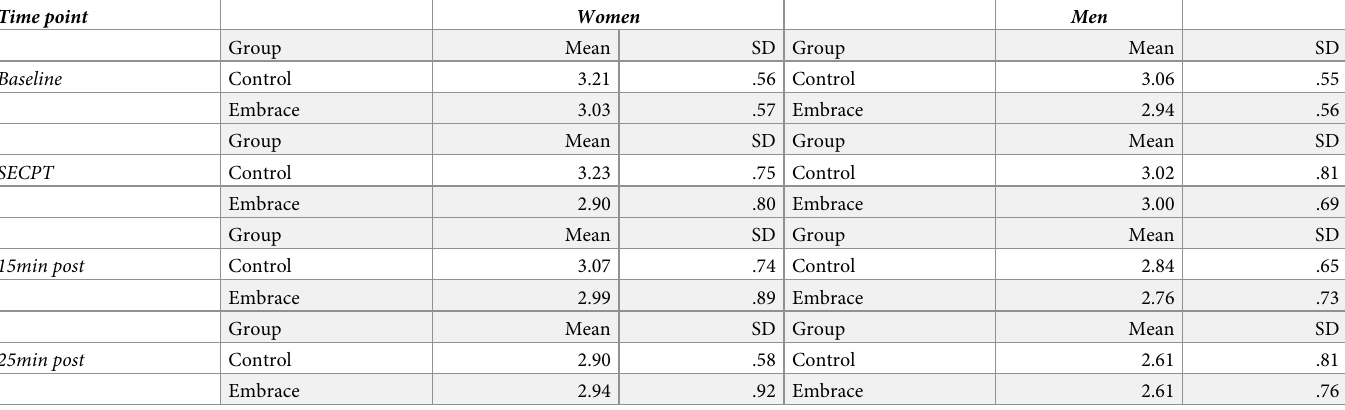
Table 4. Descriptive values (mean value and standard deviation) of positive PANAS values across the four measurement time points broken down by condition and sex. Time point Baseline